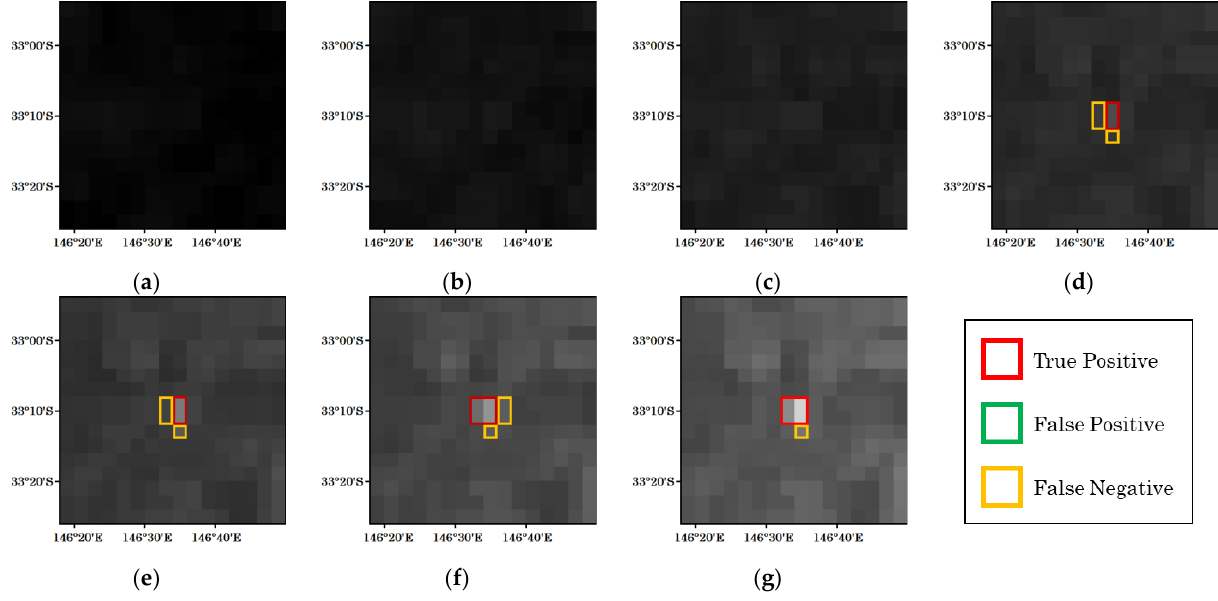
Figure 6. Example of detection results for a forest fire that occurred at 21:00 UTC on 18 February 2021. The observation times for each figure are ( a ) 20:30, ( b ) 20:40, ( c ) 20:50, ( d ) 21:00, ( e ) 21:10, ( f ) 21:20, and ( g )